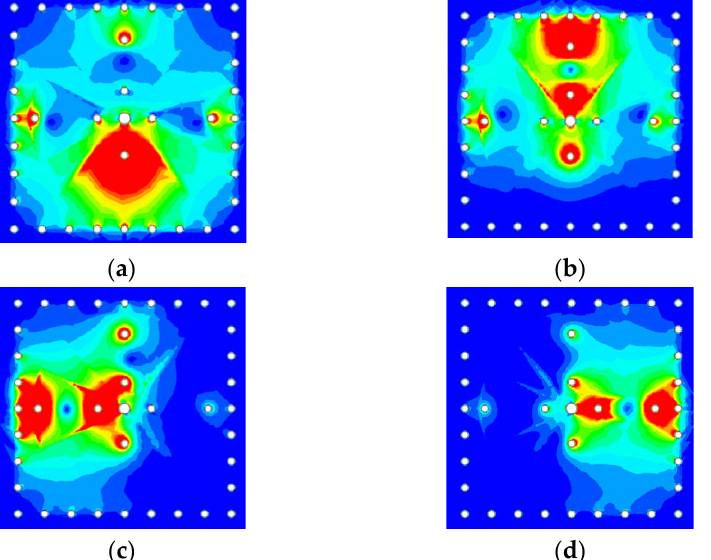
( d ) Figure 4. The magnetic field distribution on the bottom surface of metal layer M2 at the ( a ) first, ( b ) second, ( c ) third, and ( d ) fourth passband resonance frequencies. In Figure 5a–b, we present the measured and simulated frequency responses for the proposed QBF given in Figure 1. Two transmission zeros (TZs) are generated between adjacent passbands. The TZs are due to the cancellation of the magnetic and electric cou- plings, a phenomenon that can also be found in [11]. The measured (simulated) mid-band frequencies of the passbands are 1.9 (1.86), 2.62 (2.6), 3.63 (3.64) and 4.63 (4.61) GHz with the corresponding fractional bandwidths (FBW) of 3.2% (3.2%), 2.8% (3.07%), 1.4% (1.37%) and 1.7% (2.1%), respectively. The measured and simulated minimum in-band insertion losses (from the low band to the high band) are 1.9 (1.86), 1.7 (1.6), 2.1 (2.3), and 2.2 (1.8) dB. Although independent control of the four passband center frequencies has been achieved, our design has not devised that of the four passband FBWs. To independently